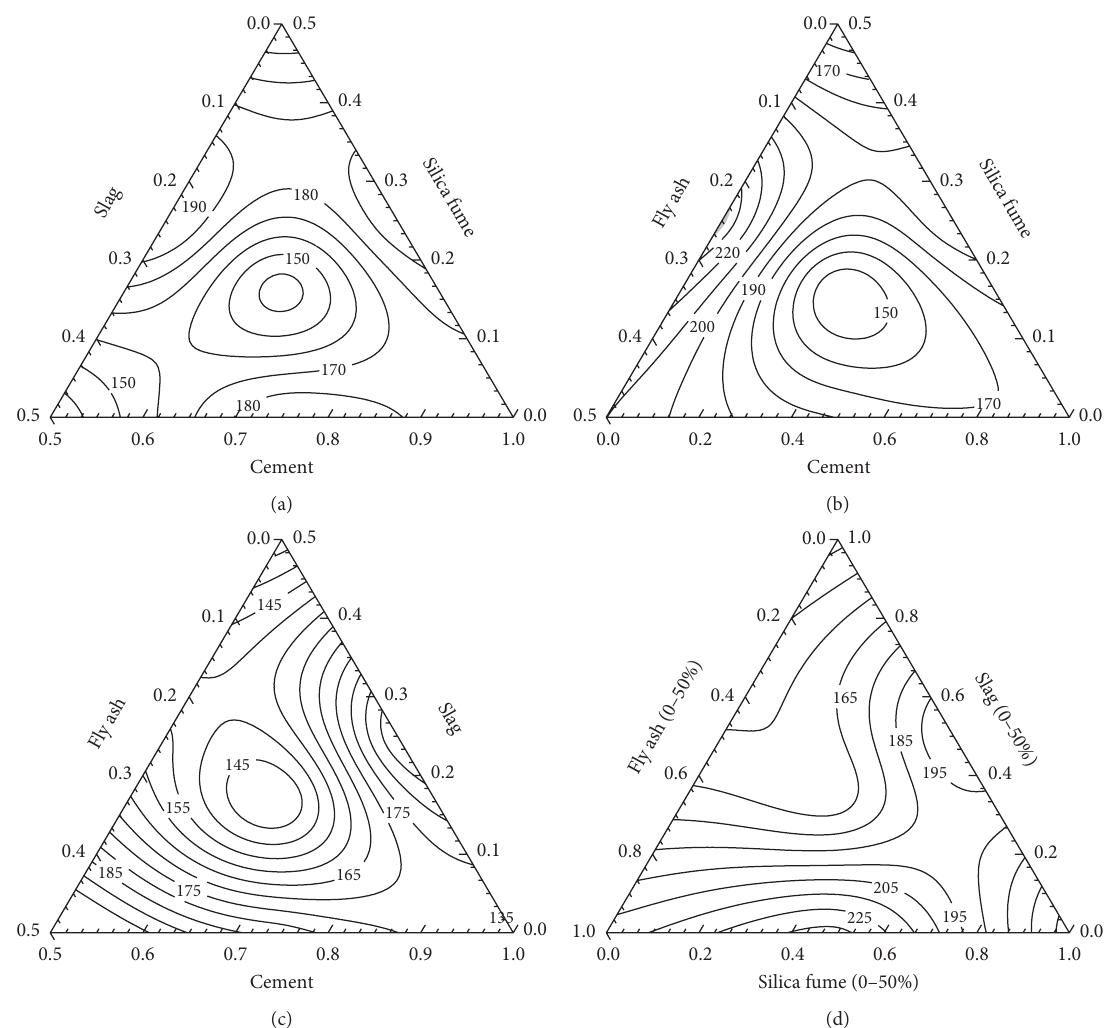
Figure 5: Flowability of UHPC with cement-silica fume-slag-fly ash binder (Sika).